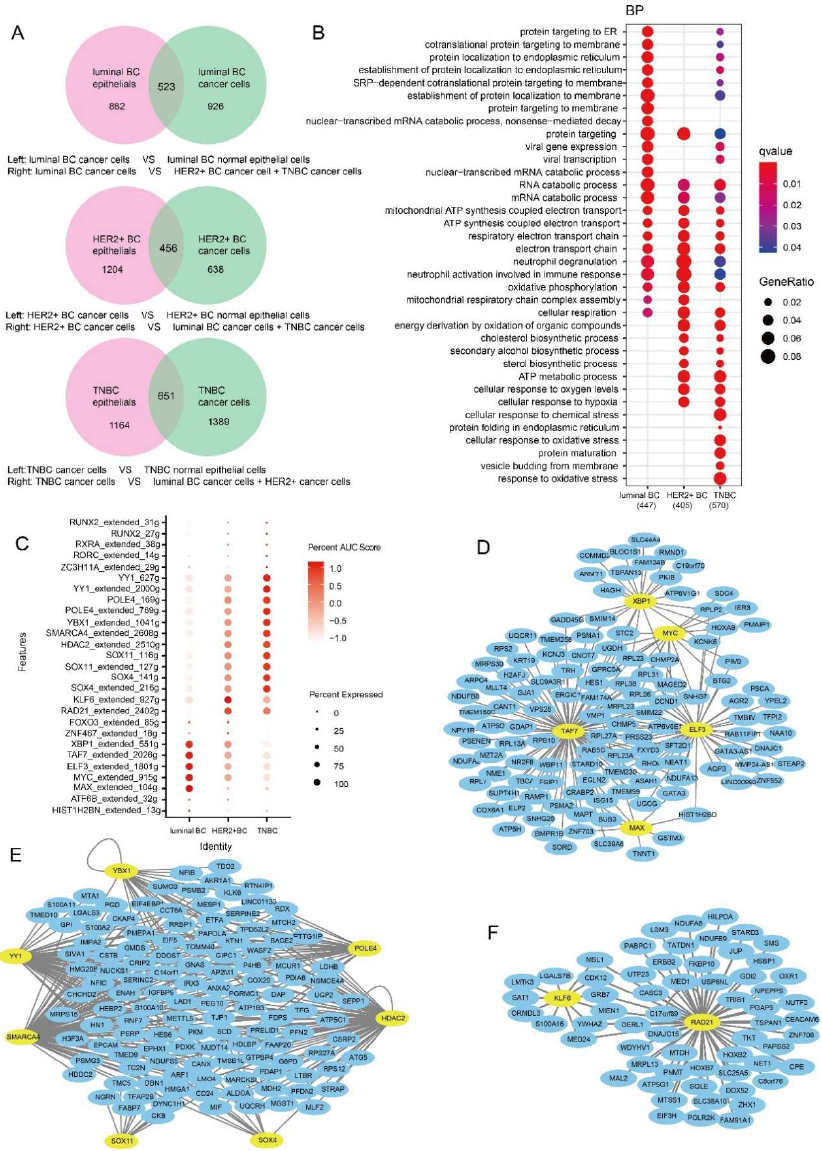
Figure 3. Functions and gene regulatory networks of subtype-specific upregulated genes. ( A ) Intersection of differentially upregulated genes in cancer cells compared with normal epithelial cells ( left ) and differentially upregulated compared with other subtypes ( right ). ( B ) GO biological process function enrichment of specific upregulation genes in cancer cells of three BC subtypes. ( C ) Dotplot showing TFs specifically enriched in cancer cells of different BC subtypes. ( D – F ) Key TFs and their highly upregulated target genes in ( D ) luminal BC, ( E ) TNBC and ( F ) HER2+ BC tumor